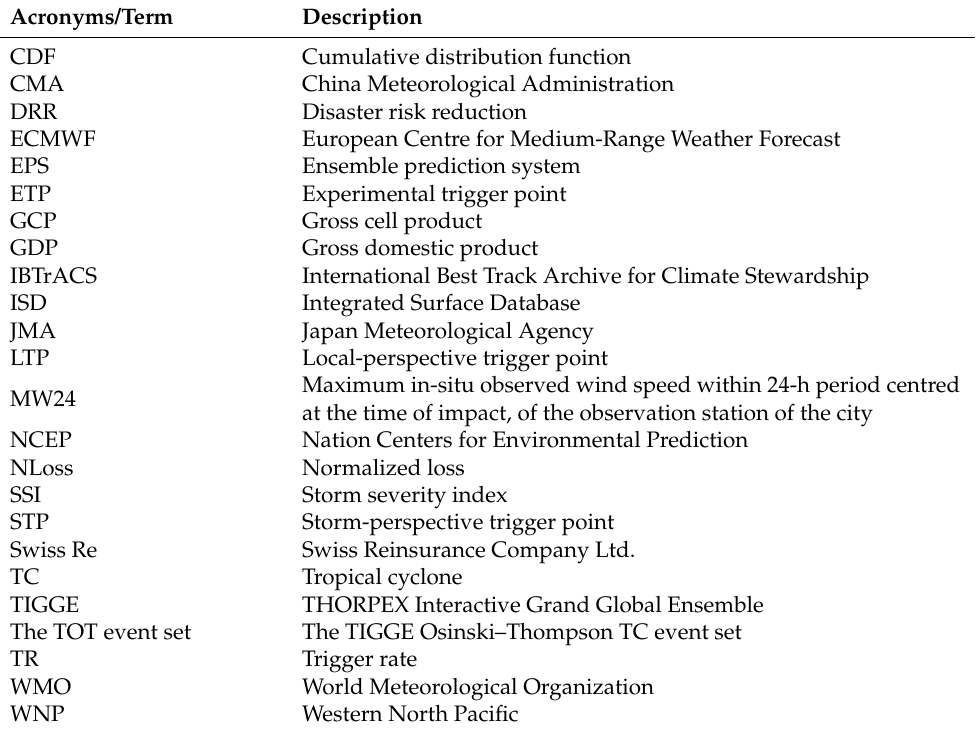
Table A1. List of